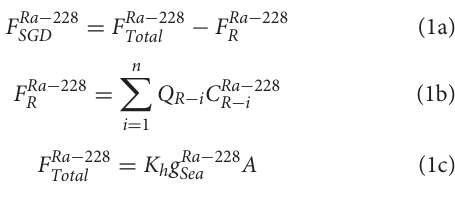
(FIA) with a detection limit of 5 µ g/L (HACH